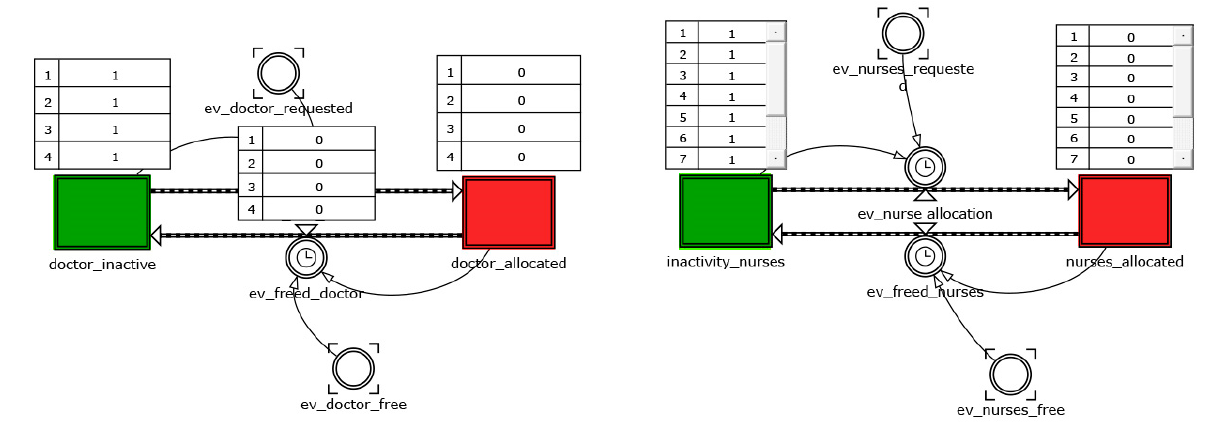
Figure 3. Resource management system.